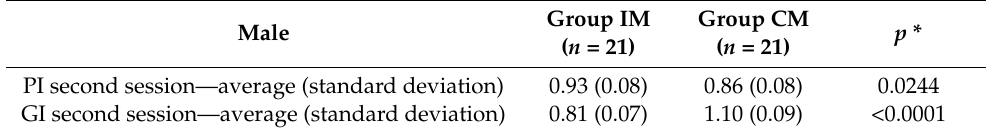
Group IM Group CM p * ( n = 21) ( n = 21)